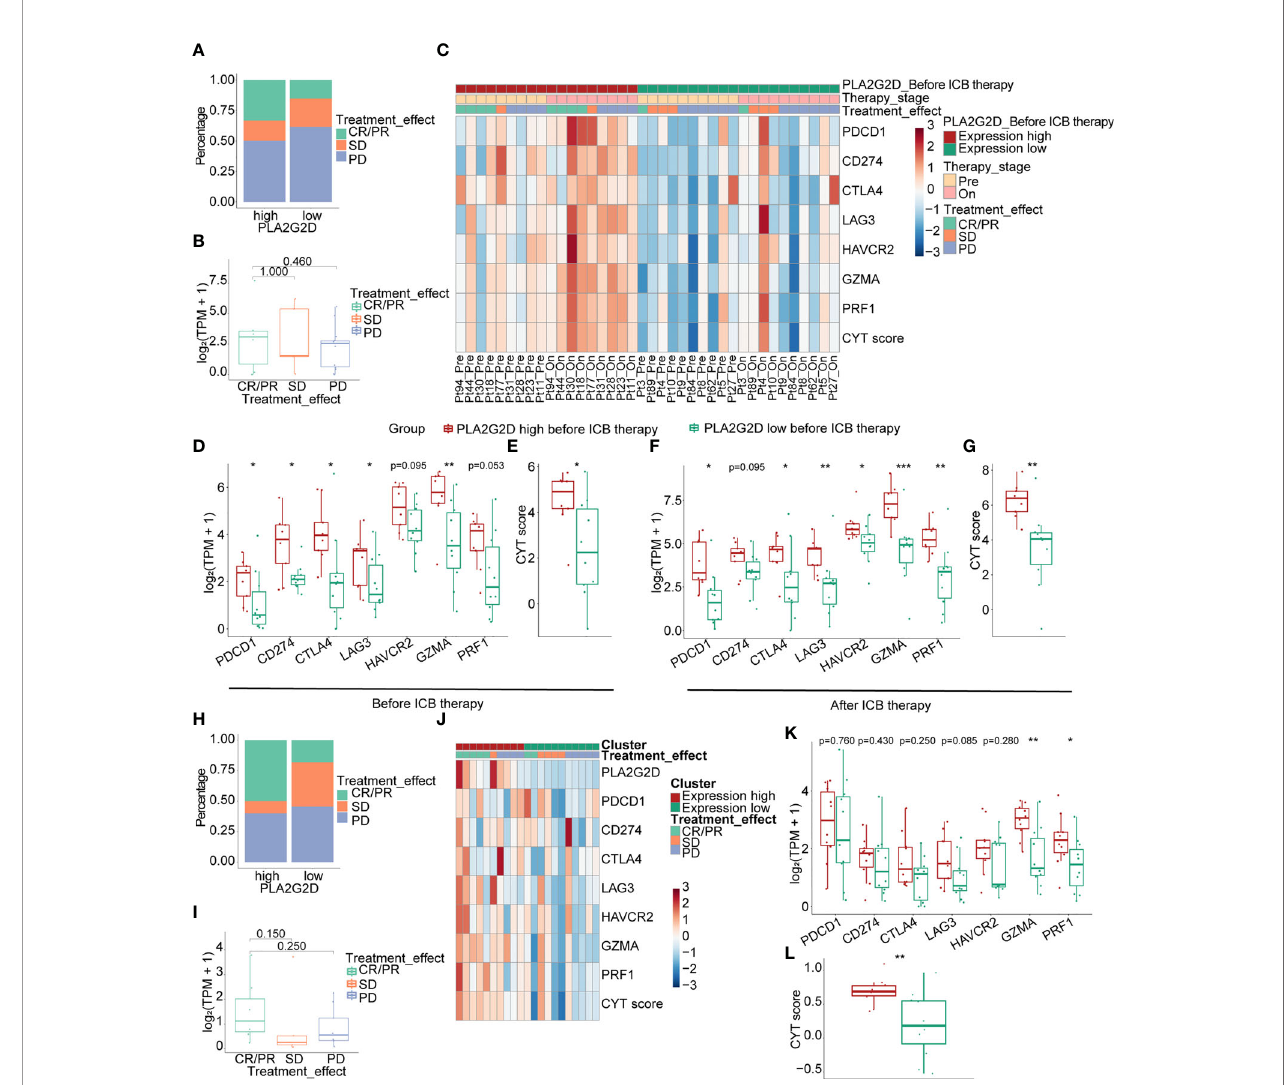
FIGURE 9 | Correlation of the expression level of PLA2G2D and response to ICB treatment in melanoma (A – G) and urothelial carcinoma immunotherapy cohorts (H – L) . (A, B) Bar and boxplot for the relationship between PLA2G2D expression and response to ICB treatment in melanoma cohort. (C) Heatmap of the relationship of ICPs, cytotoxic genes, and CYT score with different PLA2G2D expression levels and response to treatment in paired pre- and on-treatment patients. Boxplots showing the differential expression of ICPs, cytotoxic genes, and CYT scores between patients with different PLA2G2D expression levels before ICB therapy (D, E) and after ICB therapy (F, G) . (H, I) Bar and boxplot for the relationship between PLA2G2D expression and response to ICB treatment in urothelial carcinoma cohort. (J) Heatmap of the relationship of ICPs, cytotoxic genes, and CYT score with different PLA2G2D expression levels. (K, L) Boxplots showing the differential expression of ICPs, cytotoxic genes, and CYT score between patients with different PLA2G2D expression levels. * P < 0.05, ** P < 0.01, and *** P <